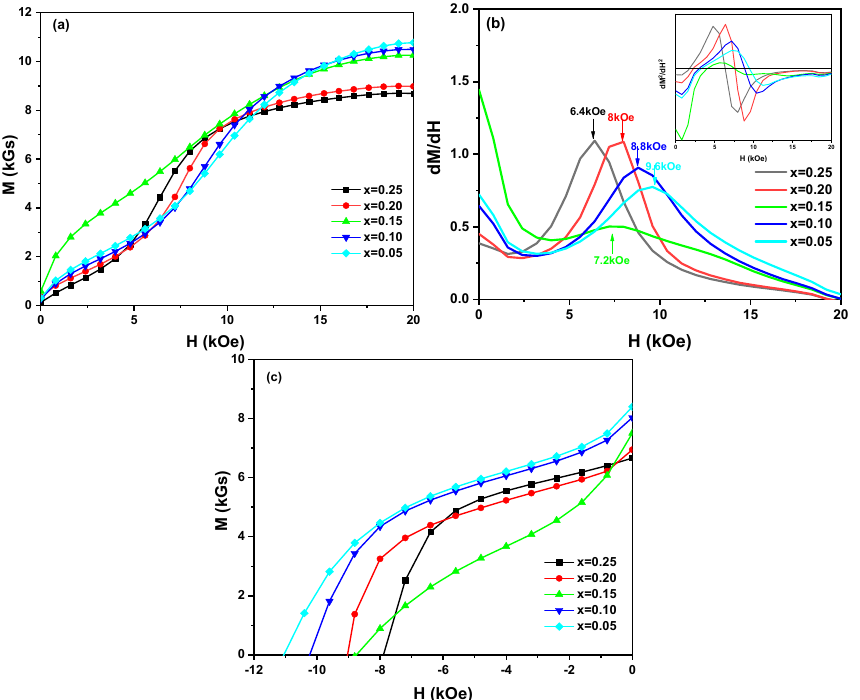
Figure 6. Initial magnetization curves ( a ), the first and second derivatives of the initial magnetization curve ( b ), and demagnetization curves ( c ) of (Nd 1-2x Ce x Y x ) 14.5 Fe 79.3 B 6.2 (x = 0.05, 0.10, 0.15, 0.20, 0.25) melt-spun ribbons at room temperature.